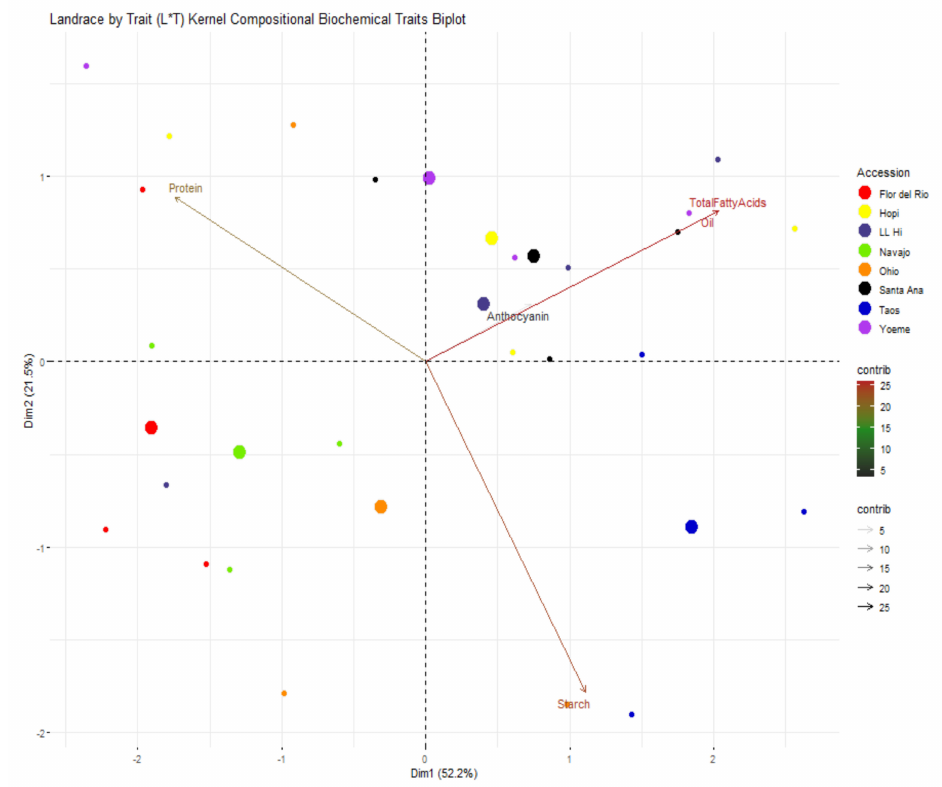
Figure 10. Landrace by trait (L*T) biplot for kernel biochemical traits. Landraces from Navajo Blue, LL High, Santa Ana Blue, Flor del Rio, Yoeme Blue, Ohio Blue, Hopi Blue, and Taos Blue are shown in “chartreuse2”, “slateblue4”, “black”, “red1”, “darkorchid2”, “darkorange”, “yellow” and “blue3”, respectively. Traits contributing to PC1 and PC2 are also assigned different colors with a gradient ranging from 5, 15, and 25 with “gray15”, ”forestgreen” and “firebrick” respectively. Larger consensus points for each accession discerns the midpoint of a given